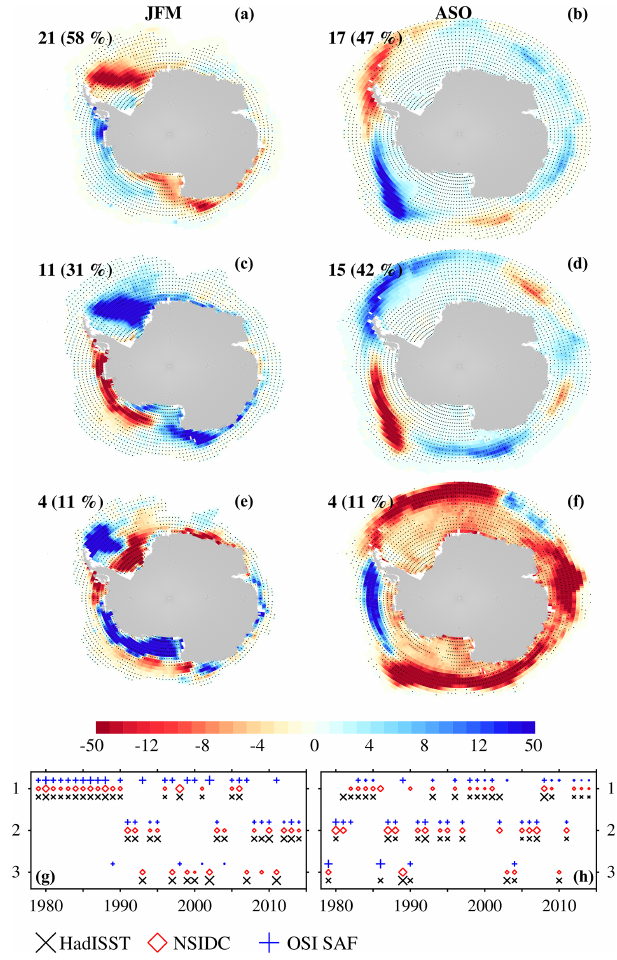
Figure 6. As in Fig. 5 but in Antarctica.